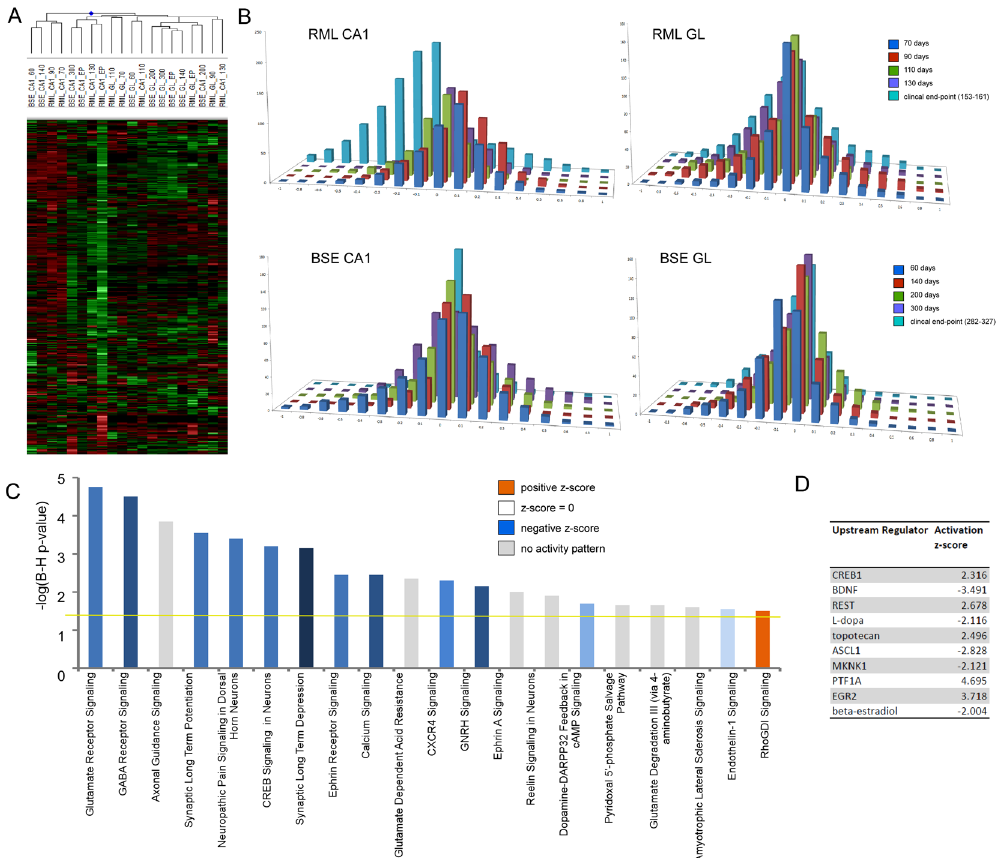
Figure 4. Dynamics and Gene Ontology analysis of genes that are enriched in neurons. ( A ) Heat map of neuron genes differentially expressed across excised hippocampal CA1 and cerebellar granule layer tissue in infections of mice with RML scrapie and BSE prions at one or more time-point after unsupervised hierarchical clustering ( n = 4–6 for each time-point). ( B ) Bar chart to show the number of neuron genes differentially expressed across excised hippocampal CA1 and cerebellar granule layer tissue in infections of mice with RML scrapie and BSE prions. The log ratio for each gene was binned in 0.1 increments along the x axis, and the number of genes in each bin on the y-axis. ( C ) IPA analysis to show the top 20 canonical pathways that were deregulated by neuron enriched genes at the clinical end-point of disease. The color of the bars indicates predicted pathway activation based on z-score (orange = activation; blue = inhibition; gray = no prediction can be made; white = z-score close to 0). The horizontal yellow line indicates the p-value threshold. Fisher’s exact test, right-tailed, was used to calculate negative log of p-value. ( D ) IPA analysis to show the top 10 predicted upstream regulators of neuron gene expression at the clinical end-point of disease based on